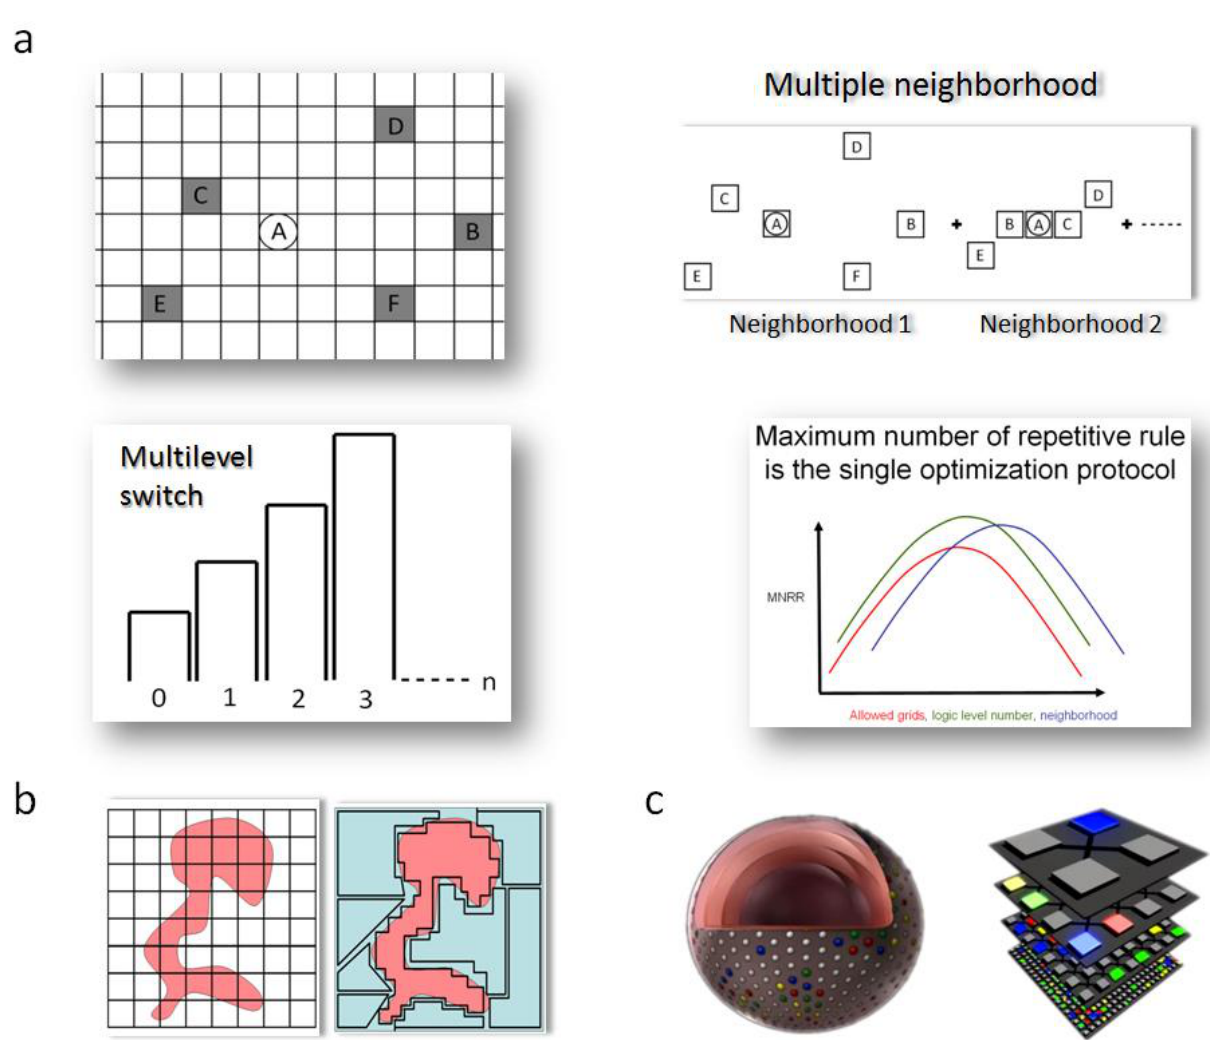
Parallel Grid Geometry: In the bottom layer of the Cube, 64 cells exist; they should represent